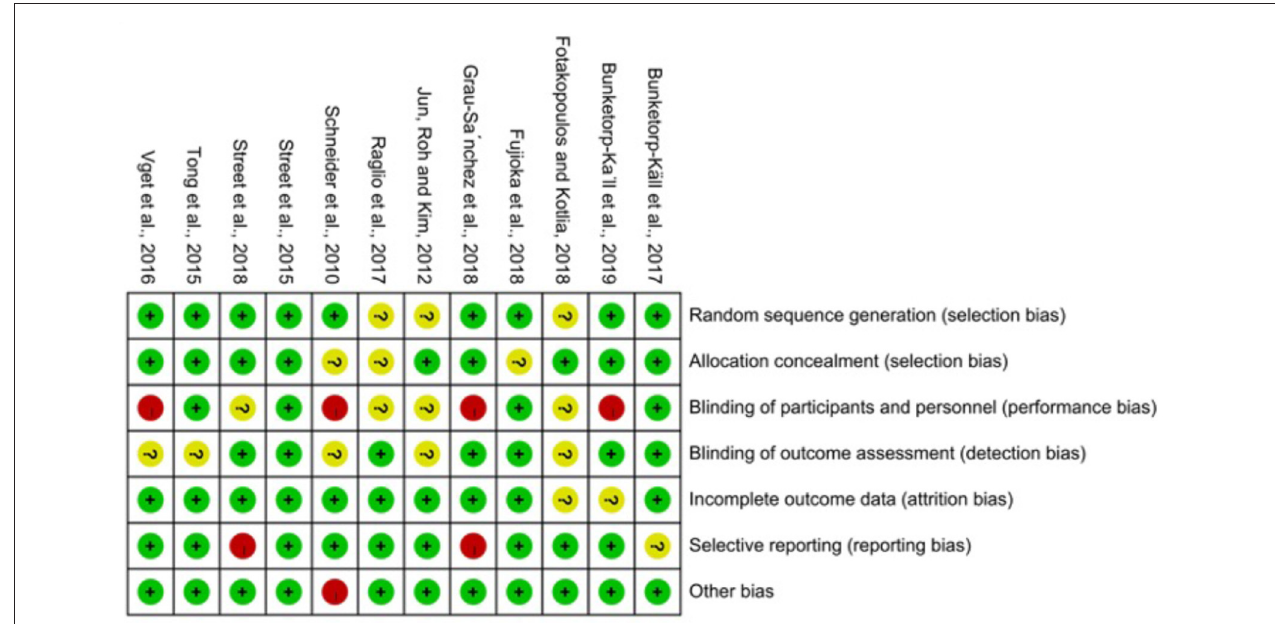
FIGURE 2 | Risk of bias summary.